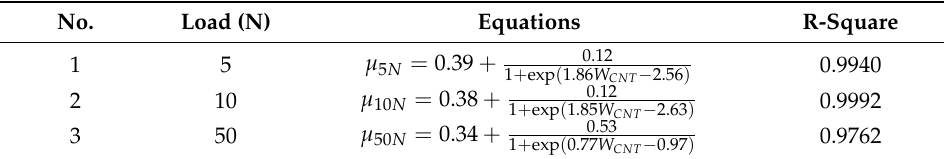
Figure 11. Friction coefficient variation as a function of CNTs content in the as-extruded AZ31 matrix at different normal loads. Table 5. Regression equations of the friction coefficient versus the content of CNTs (wt. %).